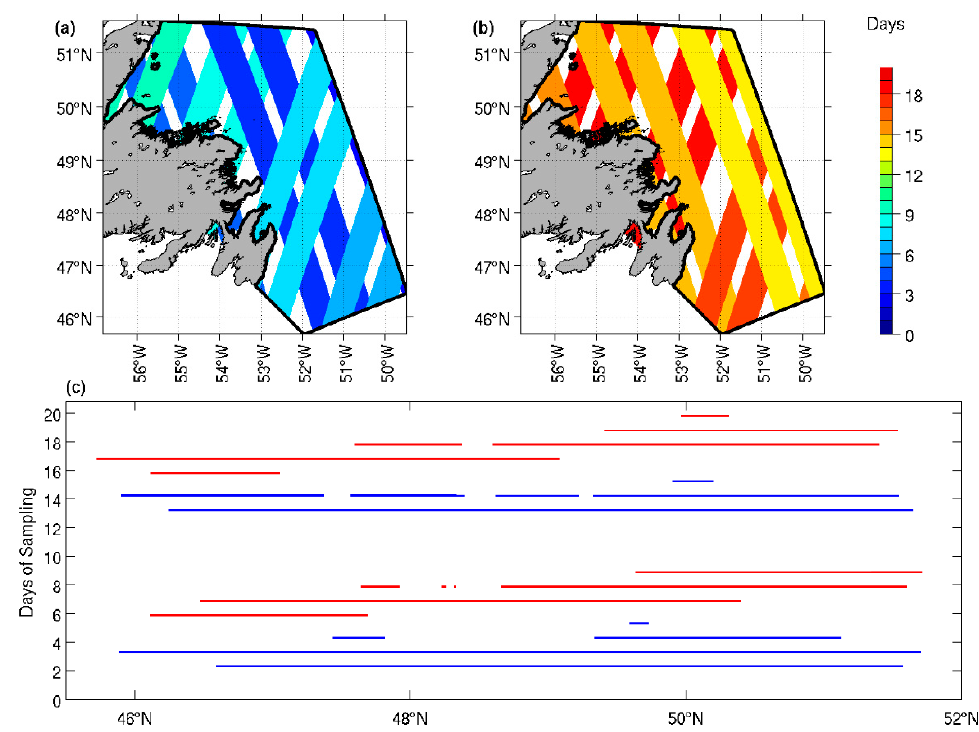
Figure 2. Spatial swath distribution within one repeat cycle of the Surface Water and Ocean Topography (SWOT) mission o ff eastern Newfoundland: ( a ) the first subcycle and ( b ) the second subcycle. ( c ) Ascending swath passes (red lines) and descending swath passes (blue lines) inside the domain as a function of time and latitude. Black lines in ( a ) and ( b ) are the border of the model domain. The unit of color band in ( a ) and ( b ) is days in the cycle.